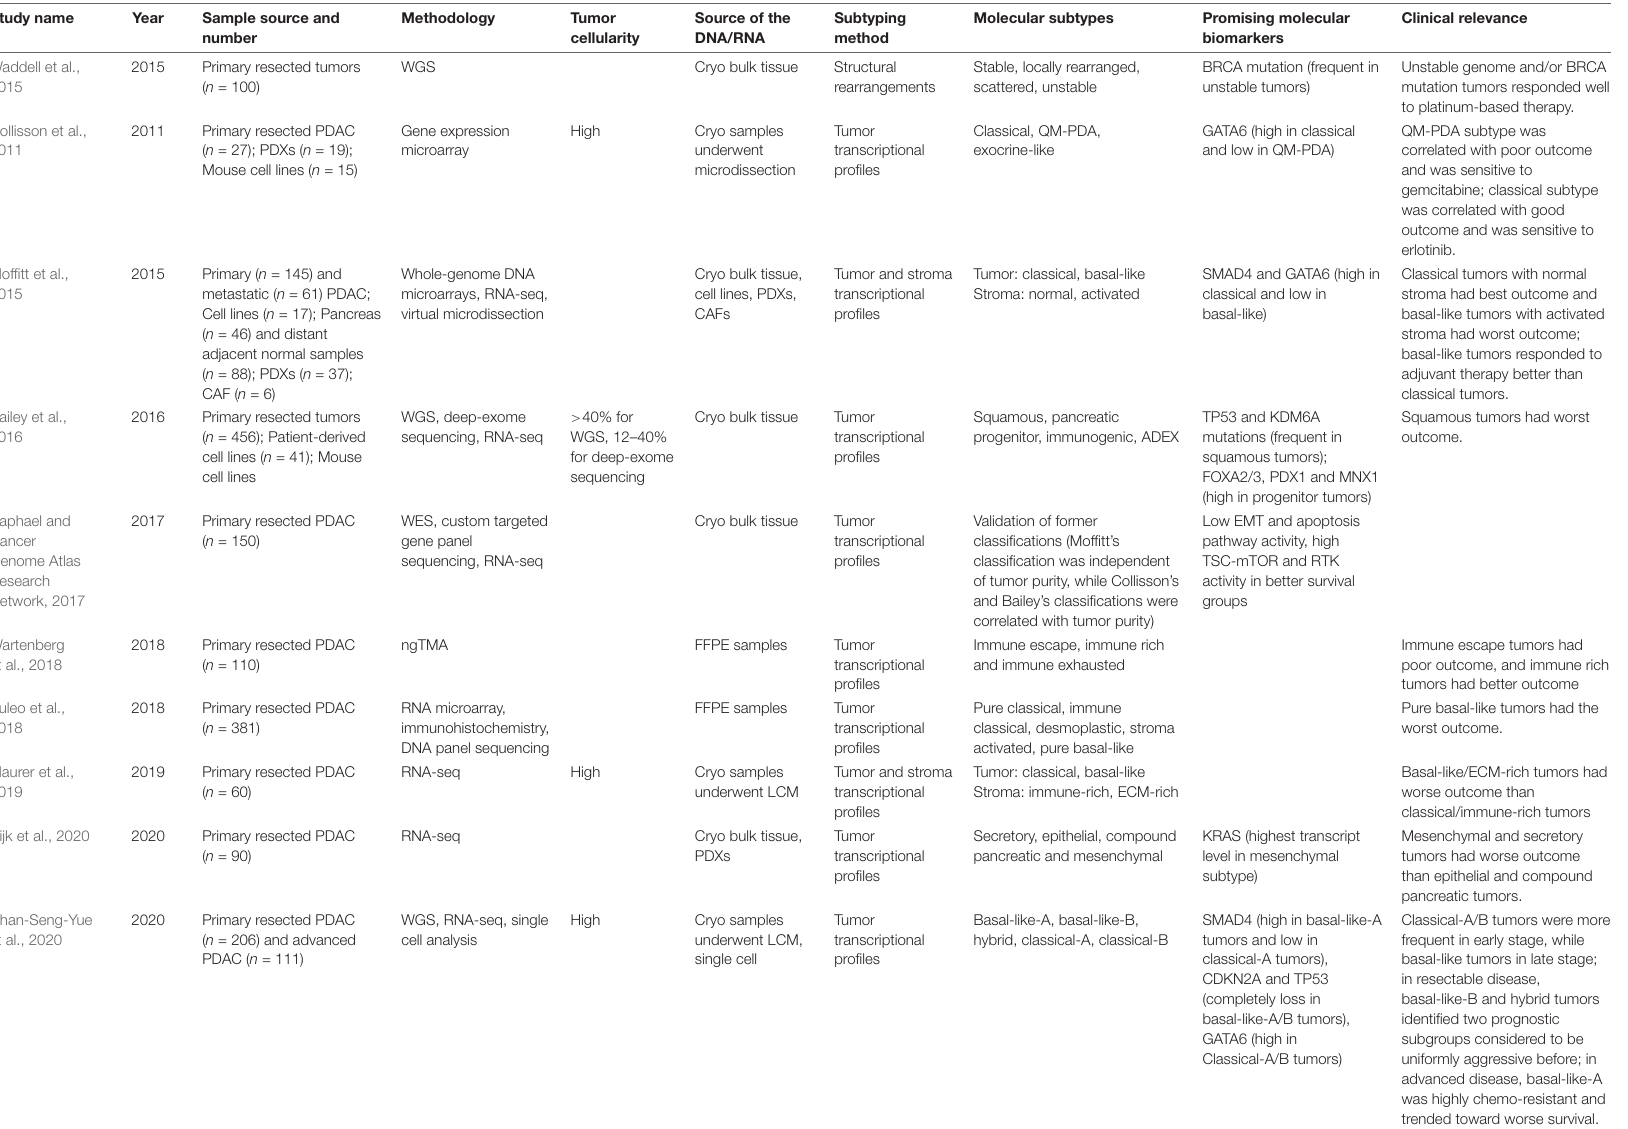
TABLE 2 | Main molecular subtypes of pancreatic cancer.